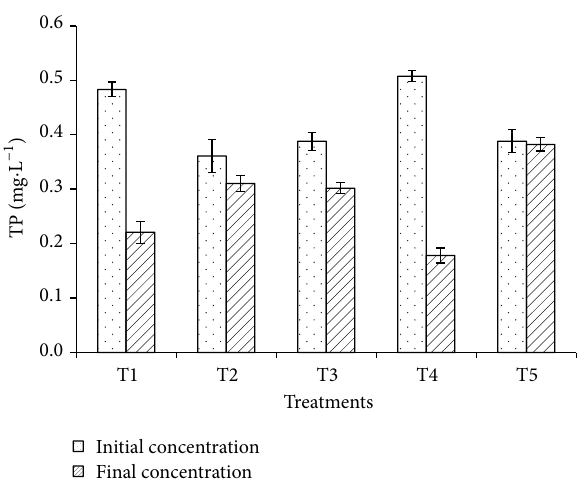
Figure 2: The change of the concentration of TP under controlled drainage at jointing-booting stage. The initial and final concentra- tions are the TP concentration in groundwater at the beginning of submergence and end of drainage, respectively. Vertical bars represent ± standard error (SE) of the mean.